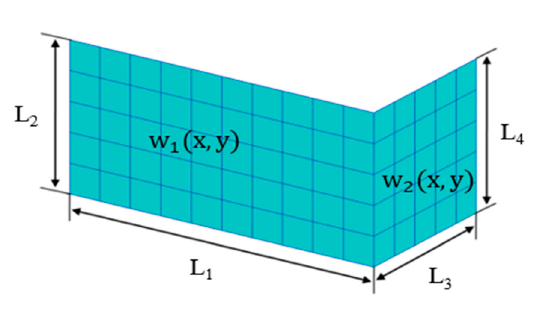
Figure 4. The model for comparison of calculated